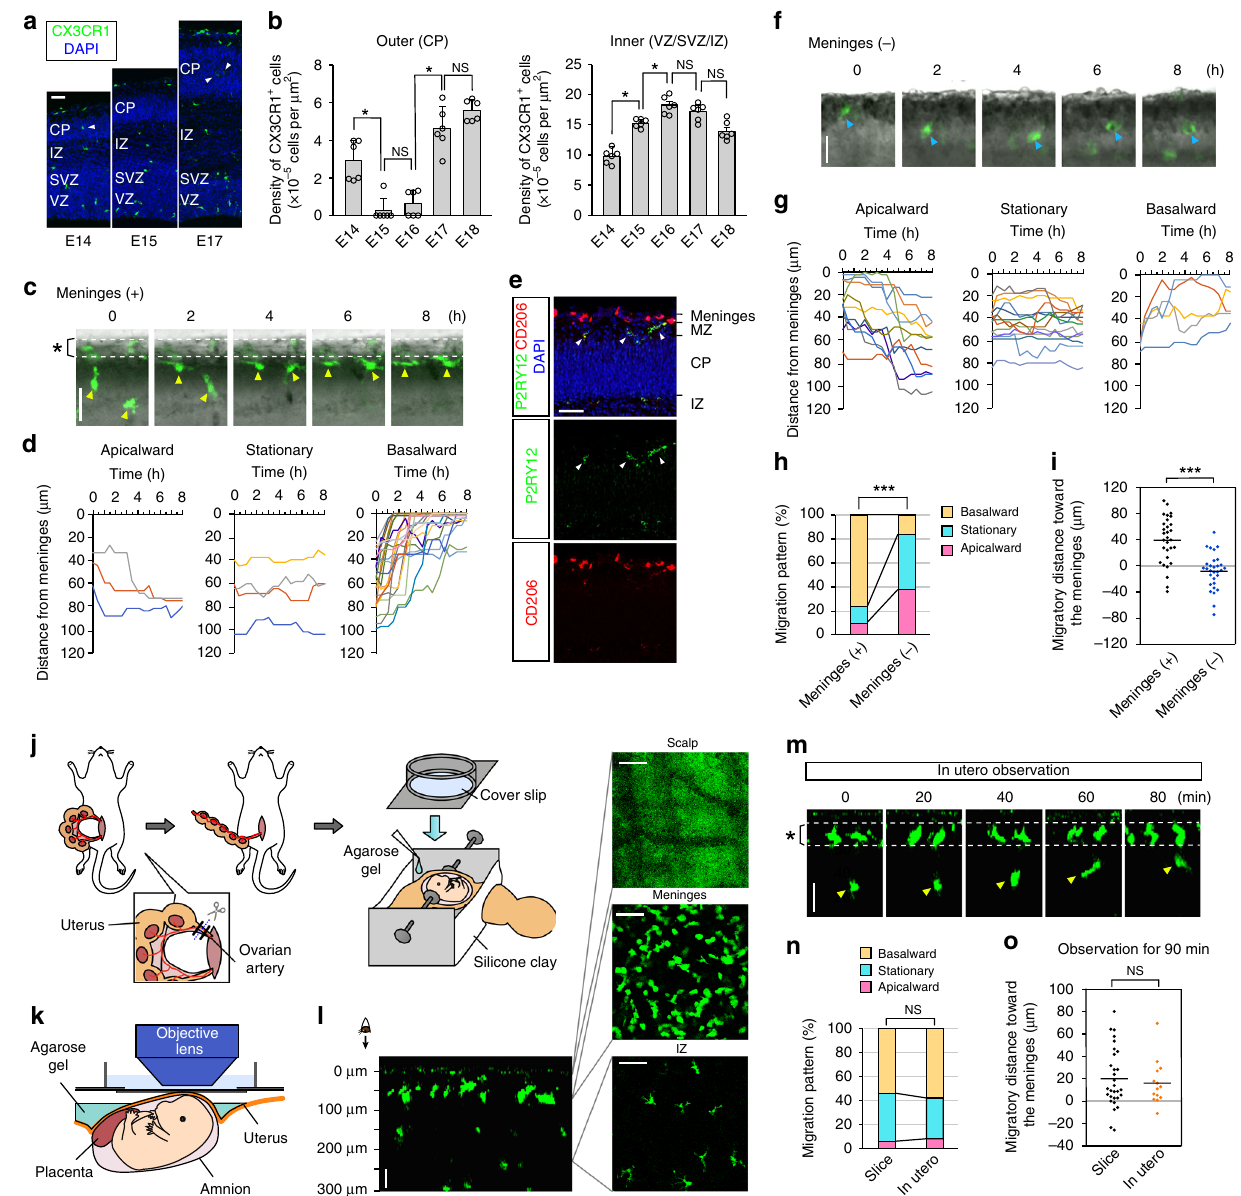
Fig. 1 Microglia exit the midembryonic CP by meninges-mediated attraction. a Immunostaining of CX3CR1 + cells in the developing mouse cortex. Arrowhead, microglia in the CP. b Comparing the density of CX3CR1 + cells through the stages in the outer and inner region. The density was determined by counting the number of cells inside an area of about 80,000 µ m 2 , which covers the dorsolateral cerebral wall in the hemisphere (two-sided Steel – Dwass test; n = 6 sections; P = 0.023, 0.912, 0.030, and 0.601 for outer, P = 0.032, 0.032, 0.703, and 0.115 for inner [left to right]). Data are presented as the mean values ± S.D. c Typical migratory behavior of CX3CR1-GFP + microglia in the CP. Arrowhead, the soma of the microglia. Asterisk, the meninges. d The trajectories of microglia that were initially in the outer region (30-min intervals for 8 h) were categorized into three groups (see Supplementary Fig. 2b). e Immunostaining for P2RY12 (microglia), CD206 (perivascular macrophages), and DAPI (nuclei) in E15 cerebral walls. Arrowheads, microglia in the MZ. f Time-lapse observation of microglia in cortical slices without the meninges. Arrowhead, the soma of the microglia. g The trajectories of the microglia in meninges-free slices are shown. A comparison of microglial translocation patterns ( h two-sided Pearson ’ s chi-squared test; P = 2.2 × 10 − 16 ) and the migratory distance toward the meninges ( i two-sided Mann – Whitney U test; n = 30 cells; P = 5.1 × 10 − 7 ). A schematic showing the procedure for surgical treatment of the mother mouse ( j ) and the installation of the embryo into the fi xing implement ( k ) for in utero observation. l Z-stack images. The right panels show the XY-image of the scalp, meninges, and IZ. m The in utero observation of microglia that migrated basalward (arrowhead). Asterisk, the meninges. A comparison of microglial translocation patterns ( n two-sided Pearson ’ s chi-squared test; P = 0.823) and the migratory distance toward the meninges ( o two-sided Mann – Whitney U test; n = 30 slices, 14 in utero; P = 0.775). Scale bar, 50 µ m. Source data are provided as a Source Data